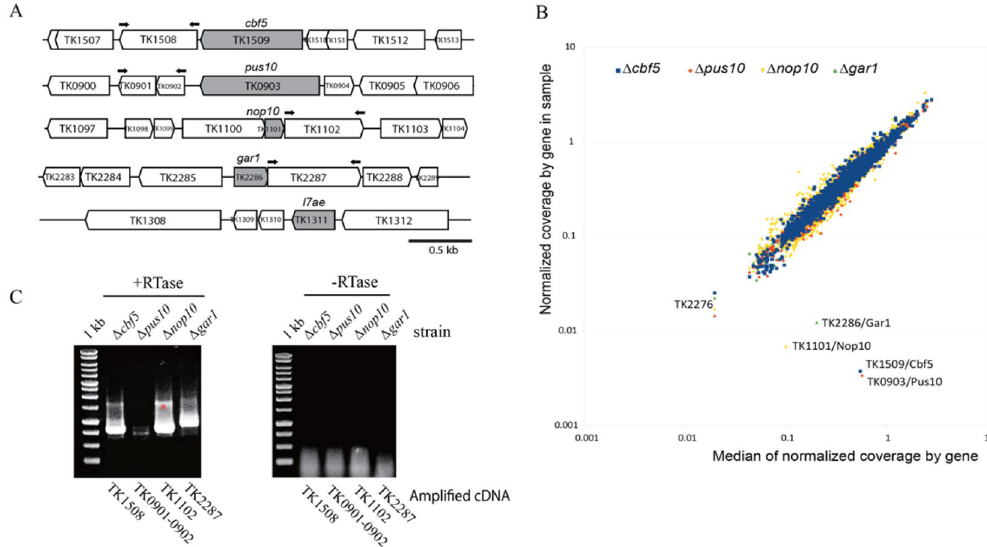
Figure 1. Construction of disruption mutants. ( A ) Schematic diagram of the loci targeted for disruption. The target genes are in gray. The black arrows indicate the primers for RT-PCR analysis (panel C and Table S3). ( B ) Normalized reads’ coverage as a function of the median coverage observed for all four deleted T . kodakarensis strains. Colors correspond to the coverage observed for Δ TK1509/ cbf5 (blue), Δ TK0903/ pus10 (red), Δ TK1101/ nop10 (yellow) and Δ TK2286/ gar1 (green) strains. Identity of outlier points is indicated. TK2276 ( pyrF ) is affected in all four strains analyzed. ( C ) Disruption of each targeted ORFs does not impair transcription of their respective downstream contiguous ORF. RT-PCR reactions (gel + RTase) were performed with oligonucleotide primers (Table S3) complementary to the coding sequence of the target gene’s adjacent ORFs (indicated below each lane). The RT-PCR products were fractionated by 0.8% agarose gel electrophoresis. The bands correspond to RNA amplification since no amplified products were obtained in a reaction mixture lacking reverse transcriptase (-RTase). The asterisk indicates non-specific